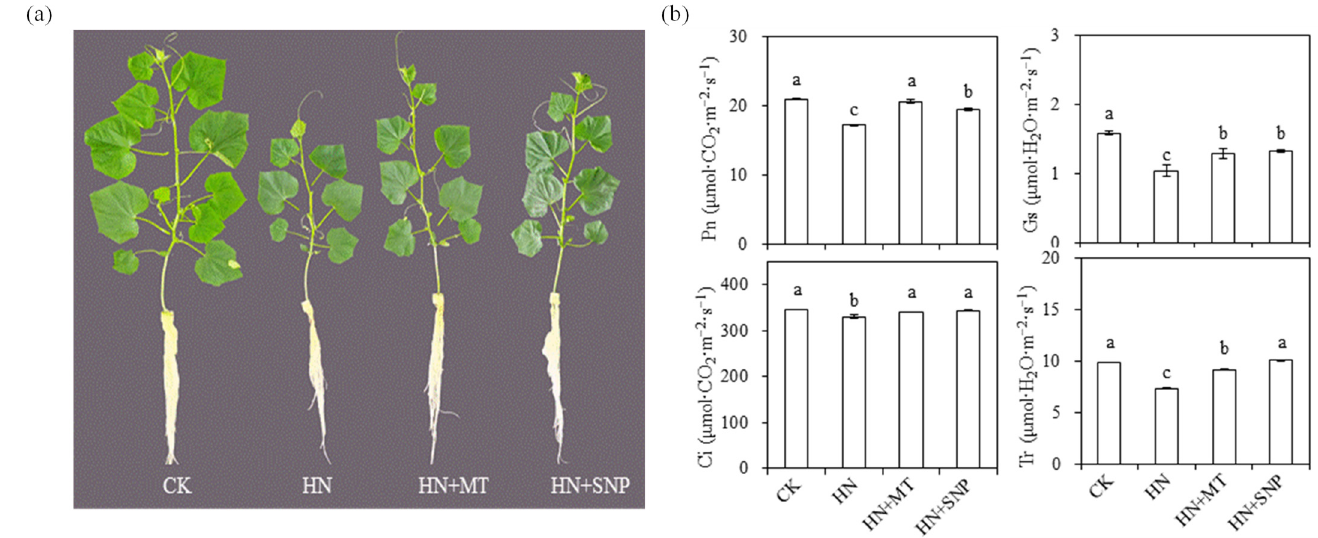
Figure 1. Effects of melatonin and nitrate oxide on the appearance of cucumber seedlings and pho- tosynthesis capacity. ( a ) Appearance of seedlings. ( b ) Photosynthesis capacity, including Pn, net photosynthetic rates. Gs, stomatal conductance. Ci, intercellular CO 2 concentration. Tr, transpiration rate. Error bars represent standard deviations of the means of three independent replicates. Different letters indicate significant differences between treatments by Duncan’s multiple range test ( p < 0.05).